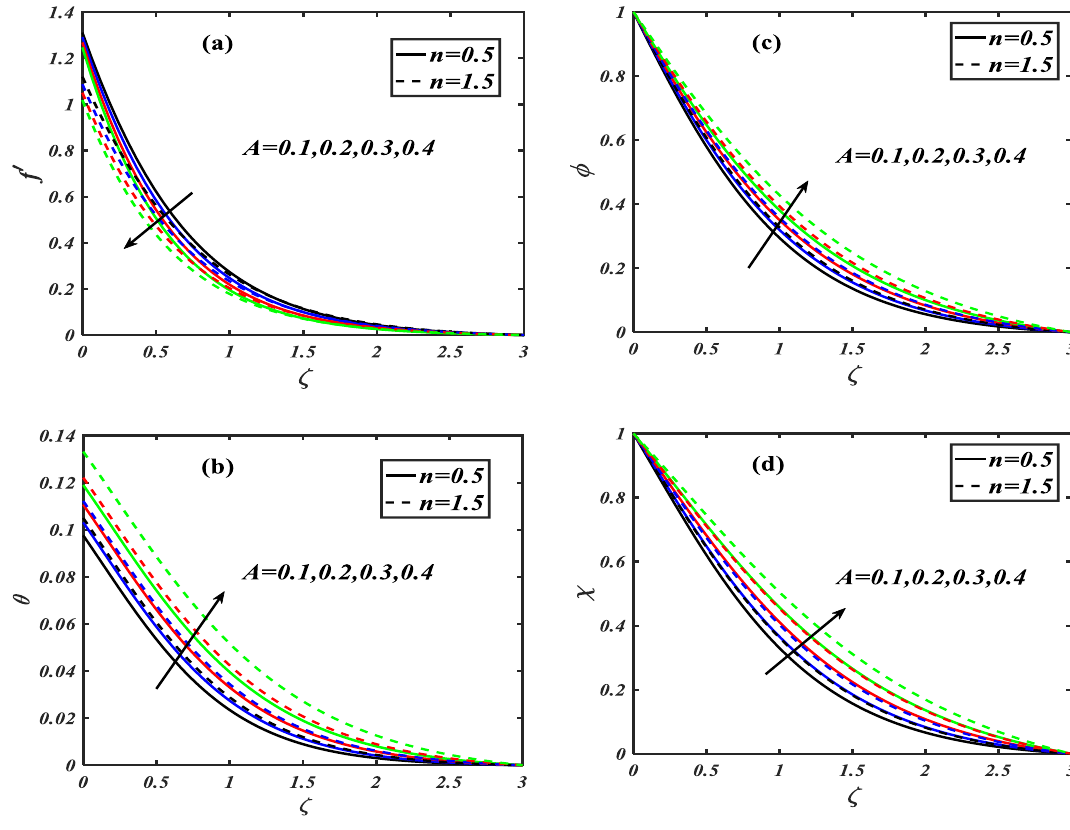
Figure 3. ( a – d ) Illustrating the effect of unsteadiness parameter on f ′ (ζ) , θ(ζ) , φ(ζ) & χ(ζ) parameter uplifted. It can assume that bio molecules that are in the base fluid become more dense then heat dis- sipation and transfer become high. The Fig. 4a–d depict the behavior of velocity slip parameter β that increases in the slip condition makes the positive effect in the geometrically and graphically in this group of graphs the variation of f ′ (ζ) which makes the down lift the curve and in others θ(ζ) , φ(ζ) and χ(ζ) respectively shows up lift behavior. Velocity slip parameter has vital role in heat transfer rate as it cause an uplift in all the parameters except velocity it is due to the increase of mass transfer rate which make the base fluid more dense and it carry less heat so its velocity field become low, in the same phenomenon concentration distribution and motility of the base fluid increases due to same factor. Figure 5a–d are depicting the behavior of magnetic parameter on velocity, boundary layer thickness, volume friction and motile density distribution in Dilatant and Pseudo plastic fluids 0.5 and n 1.5 . Figure 5a illustrates the behavior of magnetic parameter on velocity. It is inspected that n = = velocity parameter show reduction as the value of magnetic effect increases. The reason behind this decrement is basically the fluid which is magnetic, since the magnetic effect create an impact on the nanoparticles inside the fluid, and net forces become heavy which causes a decrease in fluid velocity while testing temperature field Fig. 5b is drawn for the evidence. It is observed that temperature of the nanoparticle fluid increases as the value of magnetic effect increases. The main reason for uplifting of the temperature is, magnetic parameter directly effects on the nanoparticle fluid either it is shear thinning or shear thickening. Figure 5c, d concentration profile and motile density distribution have same characteristic as temperature do. It is observed that with the increment in magnetic effect it gives a rise in concentration and motile density distribution for both dilatant and pseudo plastic fluids. Figure 6a, b illustrates the effect of Biot number Bi on concentration profile. It is noted that Biot number directly effect on concentration profile. The rise in Biot number gives a clear rise in concentration in both dilatant and pseudo plastic fluids. Figure 7a, b depicts the effects of Brownian motion Nb on temperature and concentration profile. It is seen that when the value of Brownian motion is increased it gives a rise in tempera- 0.5 and n 1.5 . While in case of testing ture as Brownian motion directly effects on temperature for both n = = concentration profile in behaves opposite to temperature, it is seen that concentration profile falls down when 0.5 and n 1.5 . Thermophoresis is the phenom- the value of brown motion is increased for both the cases n = = enon which is the cause that makes nanoparticles of the fluid flow from hot region to cold region. In testing with dilatant and pseudo plastic fluids the behavior of thermophoresis on volume friction is inspected with Fig. 8a. It exhibits that in shear thickening and shear thinning fluids concentration field increases with the incrimination